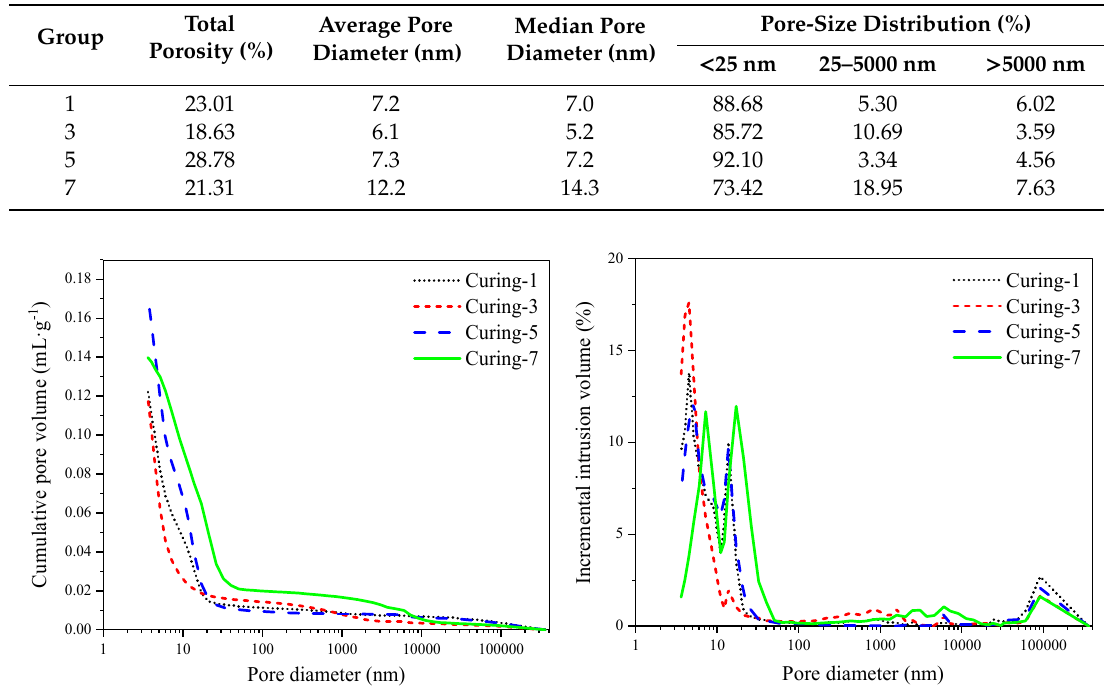
Table 8. E ff ect of early age curing on pore structure of AAS pastes.